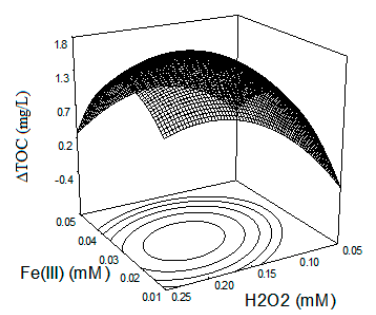
Figure 4. Effects of initial Fe 3+ and initial H 2 O 2 concentrations on the removed TOC